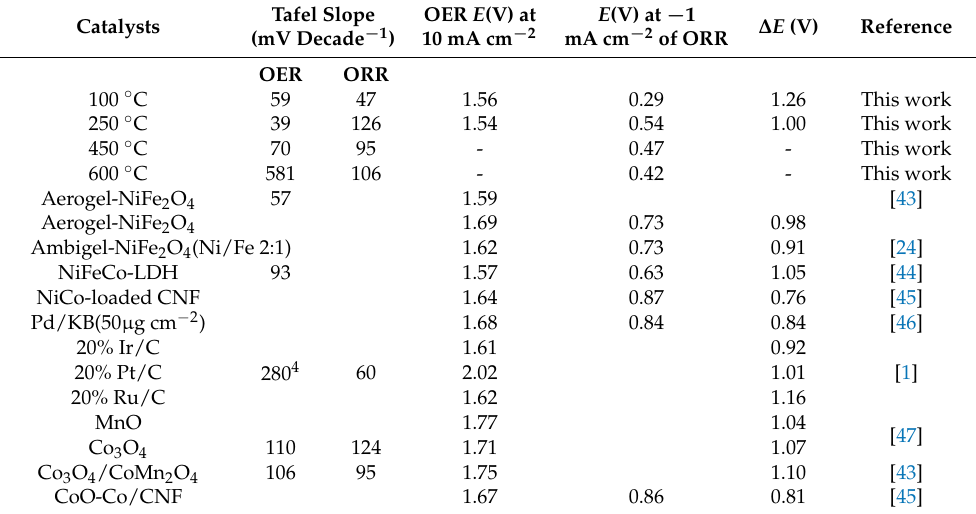
Table 3. Comparison of bifunctional oxygen electrode activities of NiFeO x with precious metal and non-precious oxide